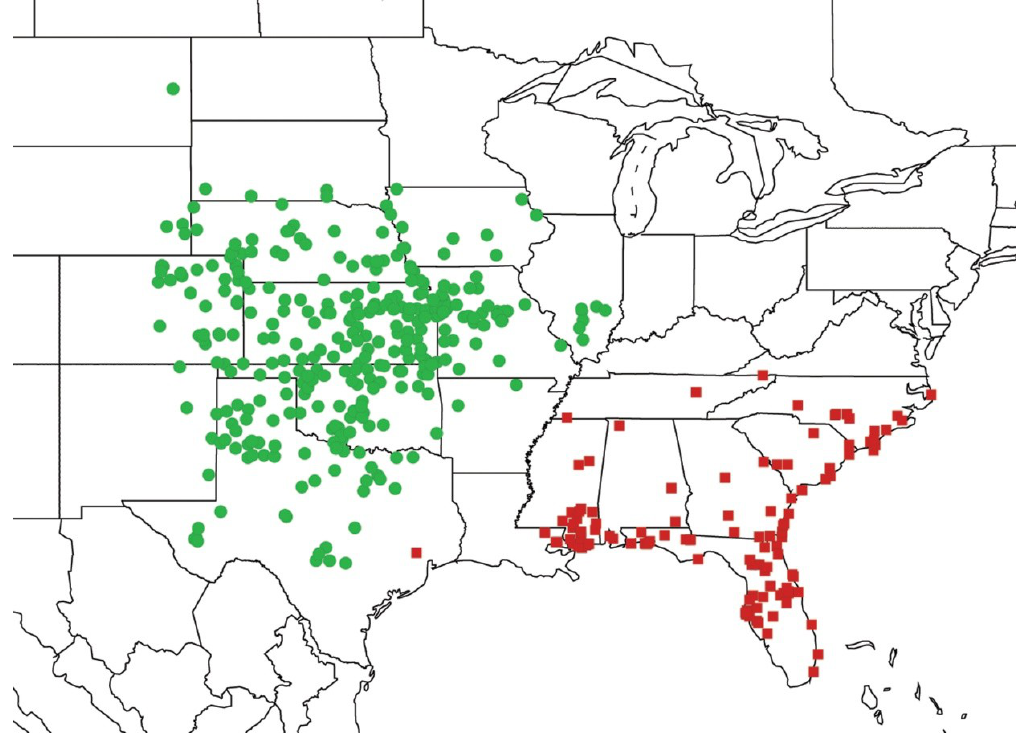
Figure 23. Distribution of Tibicen dorsatus (green circles) and T. resonans (red